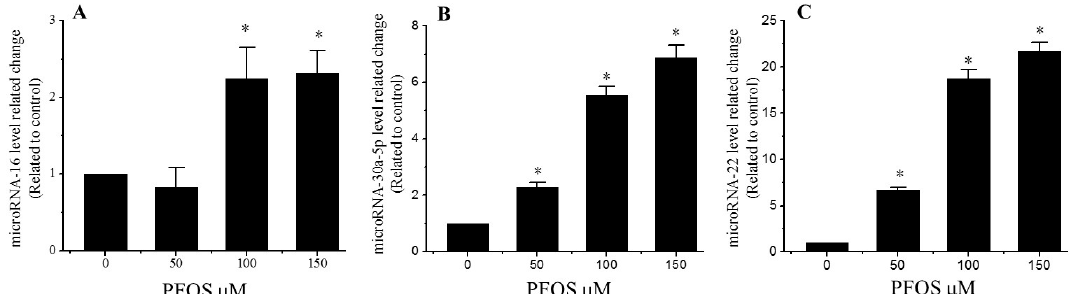
Figure 6. Effects of PFOS on the expression of mRNAs in SK-N-SH cells. Cells were cultured for 48 h with various concentrations of PFOS (50, 100, 150, 200 µ M) or DMSO (control). ( A ) mRNA levels of microRNA-16 in SK-N-SH cells; ( B ) mRNA levels of microRNA-30a-5p in SK-N-SH cells; ( C ) mRNA levels of microRNA-22 in SK-N-SH cells. Each data point was normalized to the control (DMSO), and the data are presented as mean ± SD from three independent experiments. * Compared with control: p < 0.05.